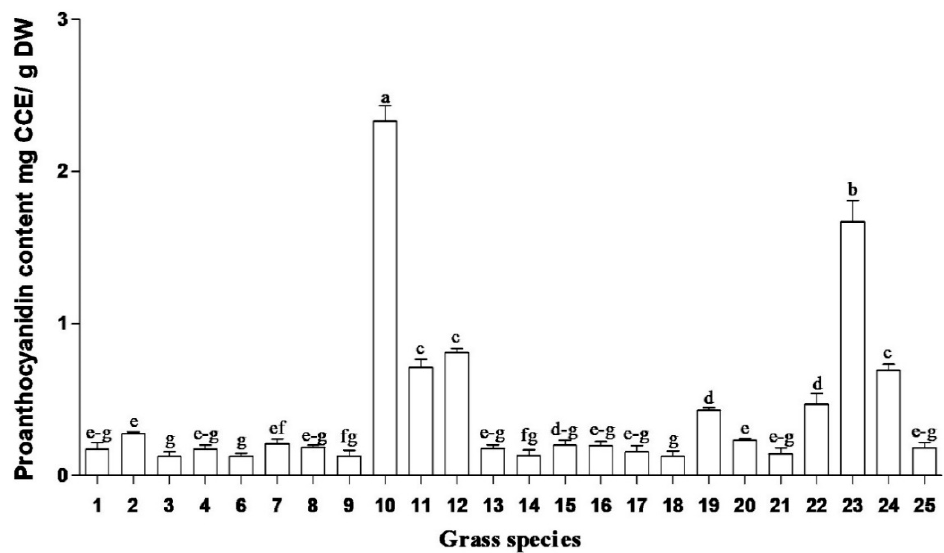
Figure 4. Condensed tannins (Proanthocynidin) in grass species used in South African traditional medicine. CCE = luecocyanidin equivalents; DW = dry weight. Bar represents mean ± standard error, n = 3. Bars with different letter(s) are significantly ( p ≤ 0.05) differences based on Duncan’s multiple range test (DMRT). (1) Coix lacryma-jobi Roots, (2) Coix lacryma-jobi Leaves, (3) Eragrostis curvula Roots, (4) Eragrostis curvula Leaves, (6) Setaria megaphylla Roots, (7) Setaria megaphylla Leaves (8) Vetiveria zizanioides Roots, (9) Vetiveria zizanioides Leaves, (10) Cymbopogon nardus Roots, (11) Cymbopogon nardus Leaves, (12) Cymbopogon nardus Inflorescence, (13) Sporobolus pyramidalis Roots, (14) Sporobolus pyramidalis Leaves, (15) Sporobolus africanus Roots, (16) Sporobolus africanus Leaves, (17) Imperata cylindrical Roots, (18) Imperata cylindrical Leaves, (19) Cenchrus ciliaris Roots, (20) Cenchrus ciliaris Leaves, (21) Panicum maximum Roots, (22) Panicum maximum Leaves, (23) Cymbopogon spp. Roots, (24) Cymbopogon spp. Leaves and (25) Cynodon dactylon Whole plant.